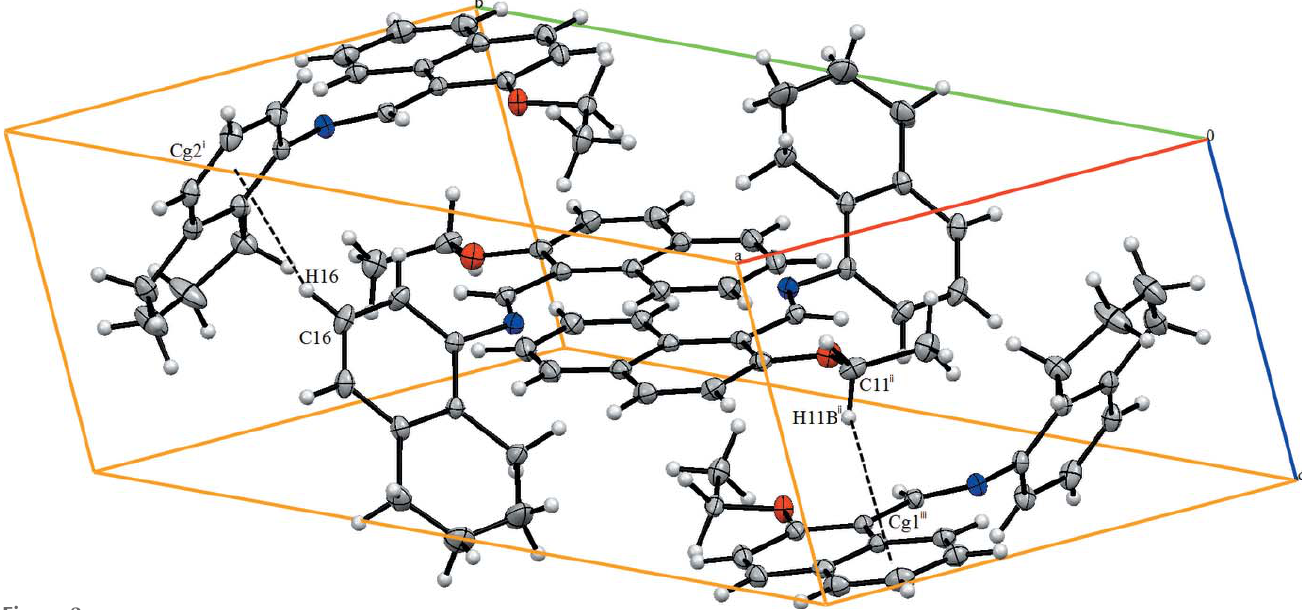
Figure 2 Aview of the crystal packing. Dashed lines denote C—H (cid:3)(cid:3)(cid:3) (cid:2) interactions. Symmetry codes: (i) x , (cid:5) y + 3